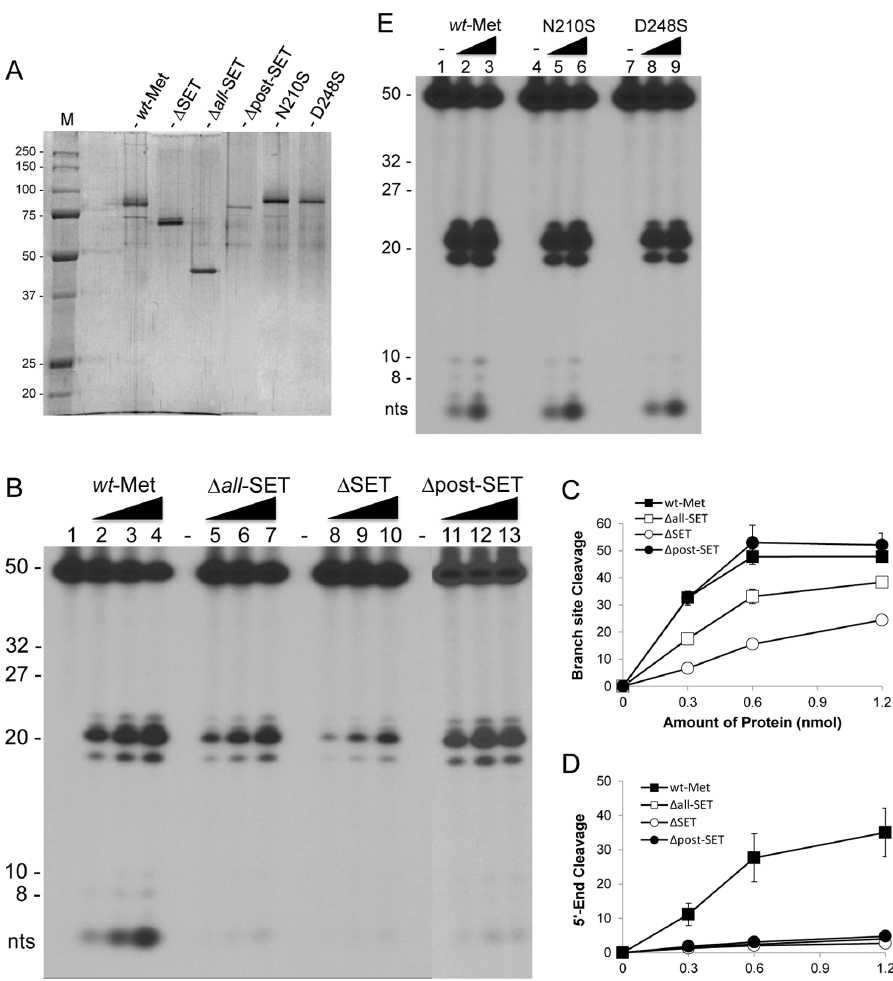
mutants following 10% SDS-PAGE. (B) Cleavage of the 5 ’ end of a 5 ’ -flap DNA with the SET deletion and the substitution mutants. Increasing amounts of wt -Metnase and the SET domain deletion mutant (panel B) were